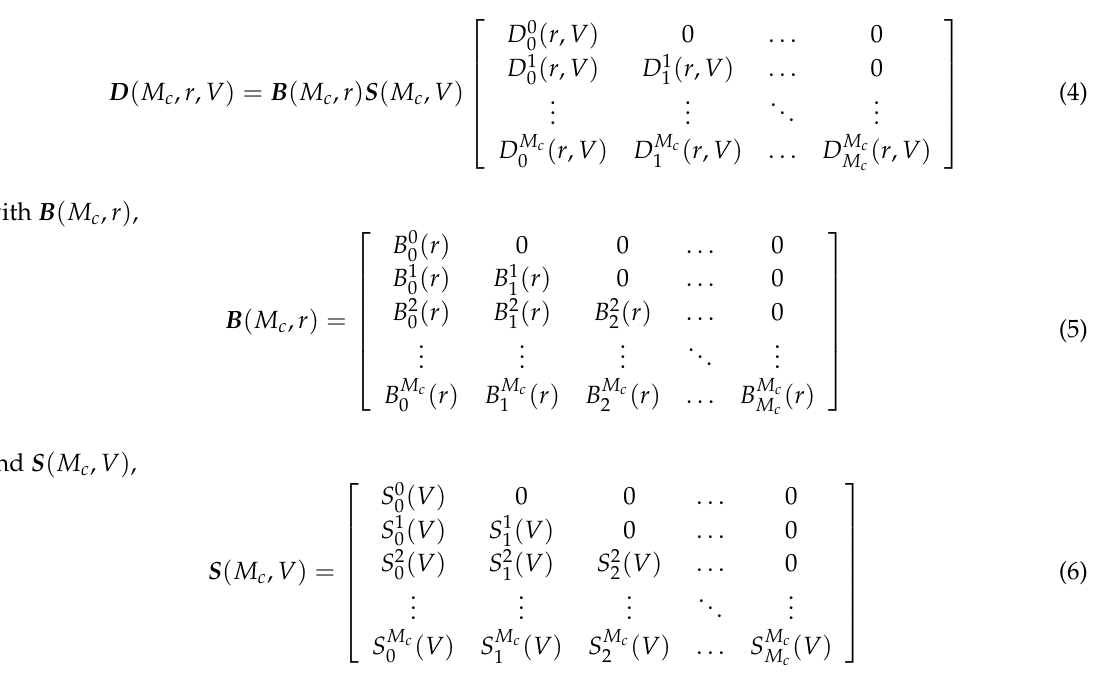
Table 4. Frame structure for nodes in A 0 ∪ S 0 ∪ A 1 and Ring ≤ 4. ( N Intra , N Inter ) = ( 4,7 ) . Frame Structure CH h